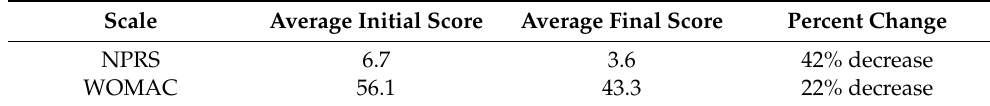
Table 1. Percent change analysis for initial and final NPRS and WOMAC scores.